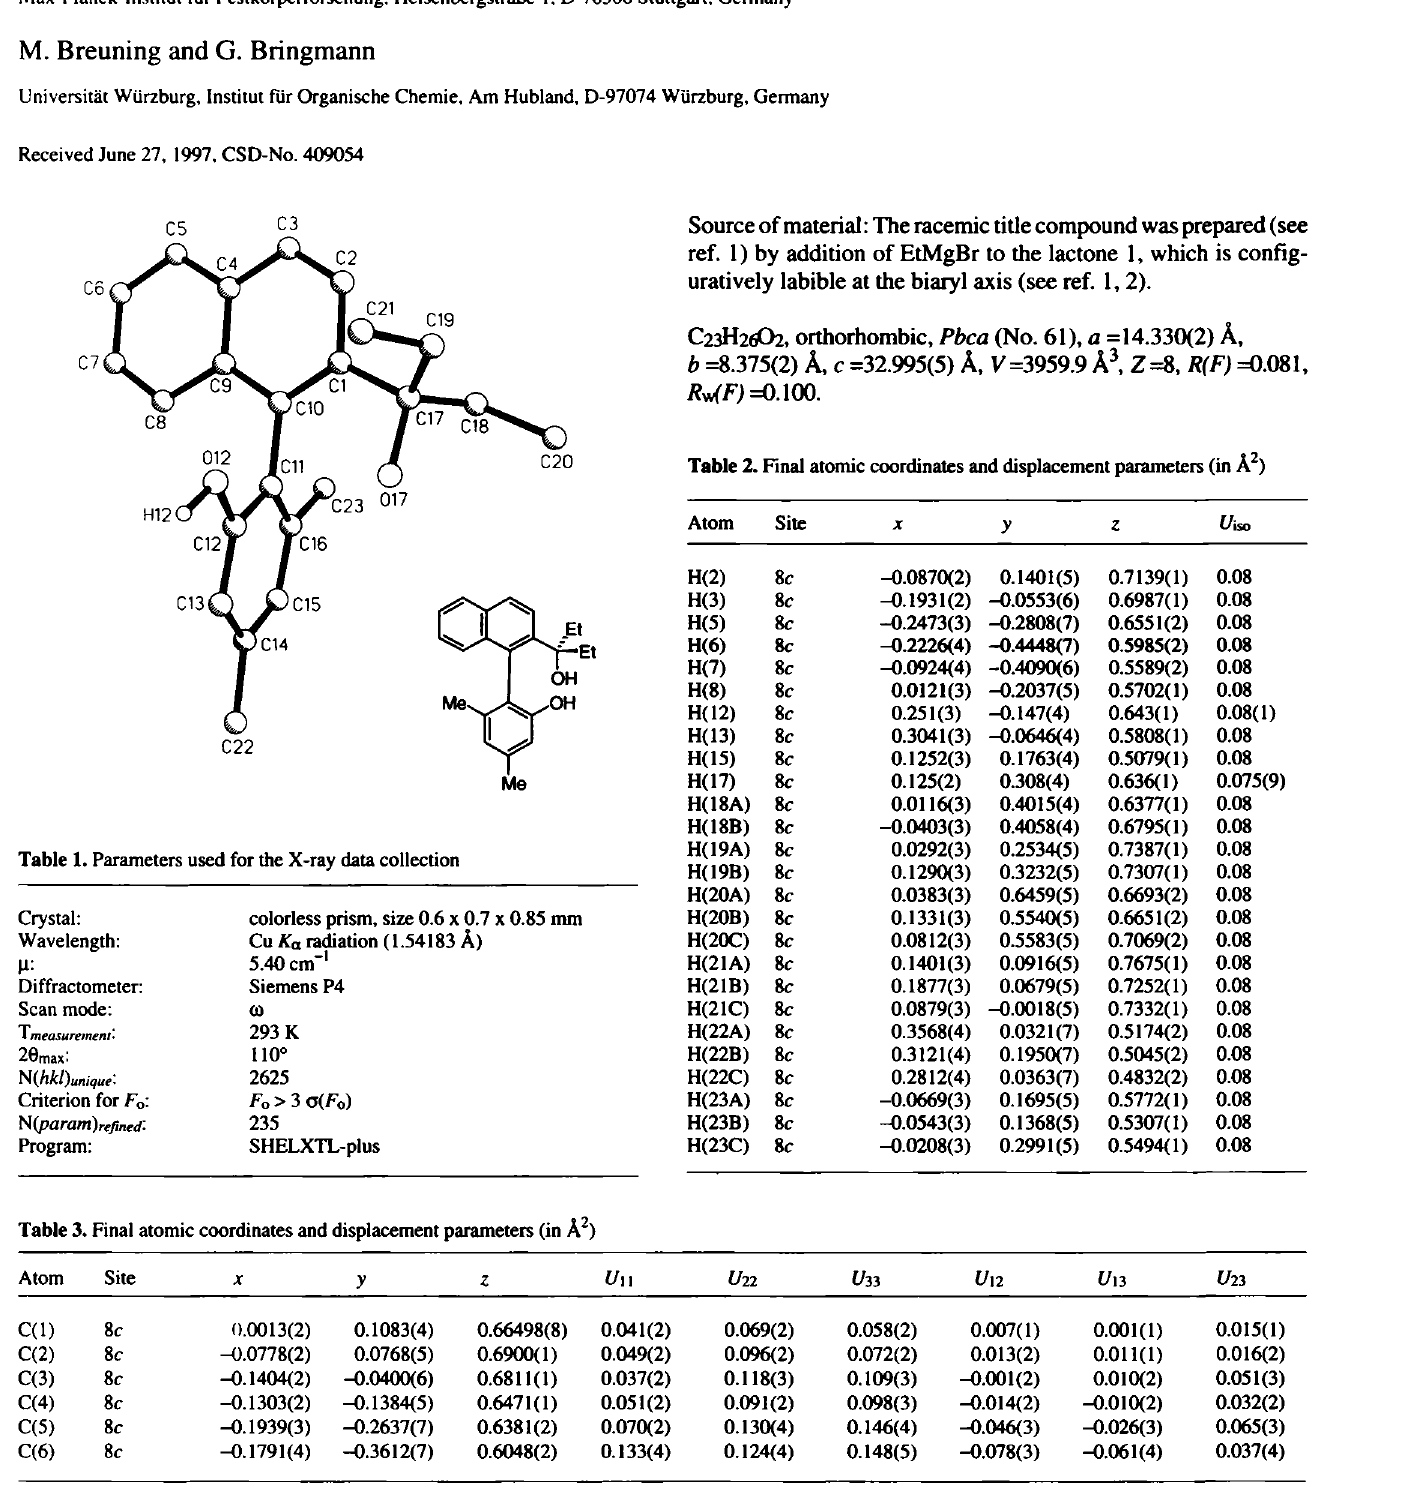
Table 1. Parameters used for the X-ray data collection